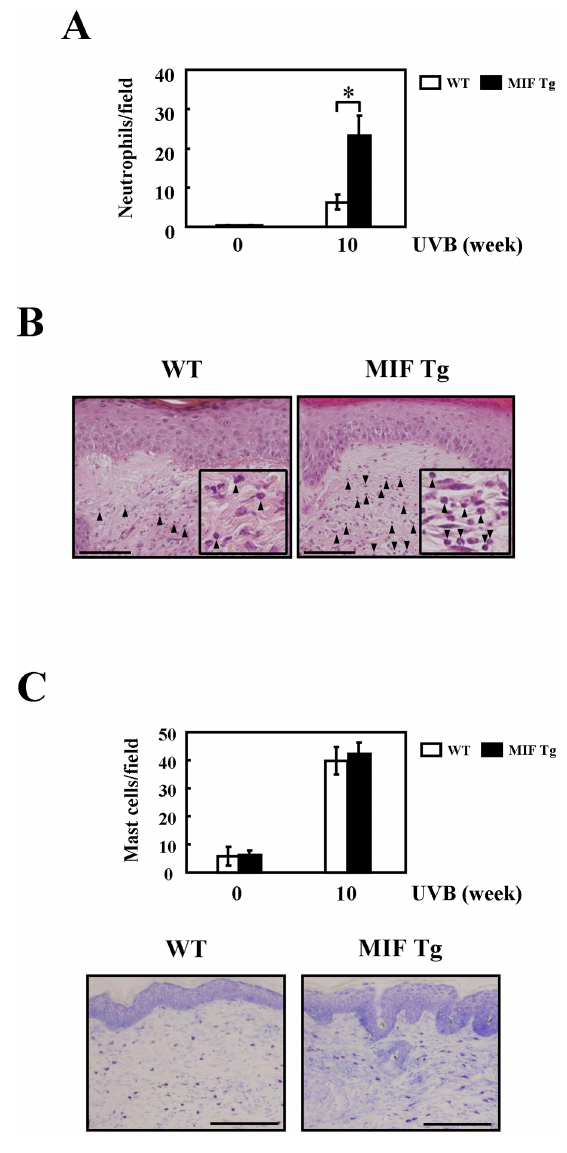
Figure 4. Effects of chronic UVB irradiation on murine skin neutrophils and mast cells. Murine skin was irradiated with UVB (300 mJ/cm 2 6 3/week) for 10 weeks. Staining of neutrophils and mast cells in the UV irradiated murine skin sections using the H&E and toluidine blue methods. (A) A quantitative analysis of the number of neutrophils in the UV irradiated (0 and 10 weeks) skin sections was analyzed by a one-way ANOVA (n=5 in each section). (B) UV irradiated skin (H&E, WT and MIF Tg mouse, 10 weeks). Arrowheads point to neutrophils. Scale bars =100 m m. (C) A quantitative analysis of the number of mast cells in the UV irradiated (0 and 10 weeks) skin sections was analyzed by a one-way ANOVA (n=5 in each section). And UV irradiated skin (Toluidine blue, WT and MIF Tg mouse, 10 weeks). Scale bars =200 m m. (The experiments were repeated two times and similar results were moter, as reported previously [33]. The strain of the original MIF Tg was ICR, and the mice were backcrossed with C57BL/6 for at least 10 generations. The Tg mice were maintained using heterozygous sibling mating. MIF Tg and wild-type (WT) mice were maintained under specific pathogen-free conditions at the Institute for Animal Experiments at the University of Toyama.